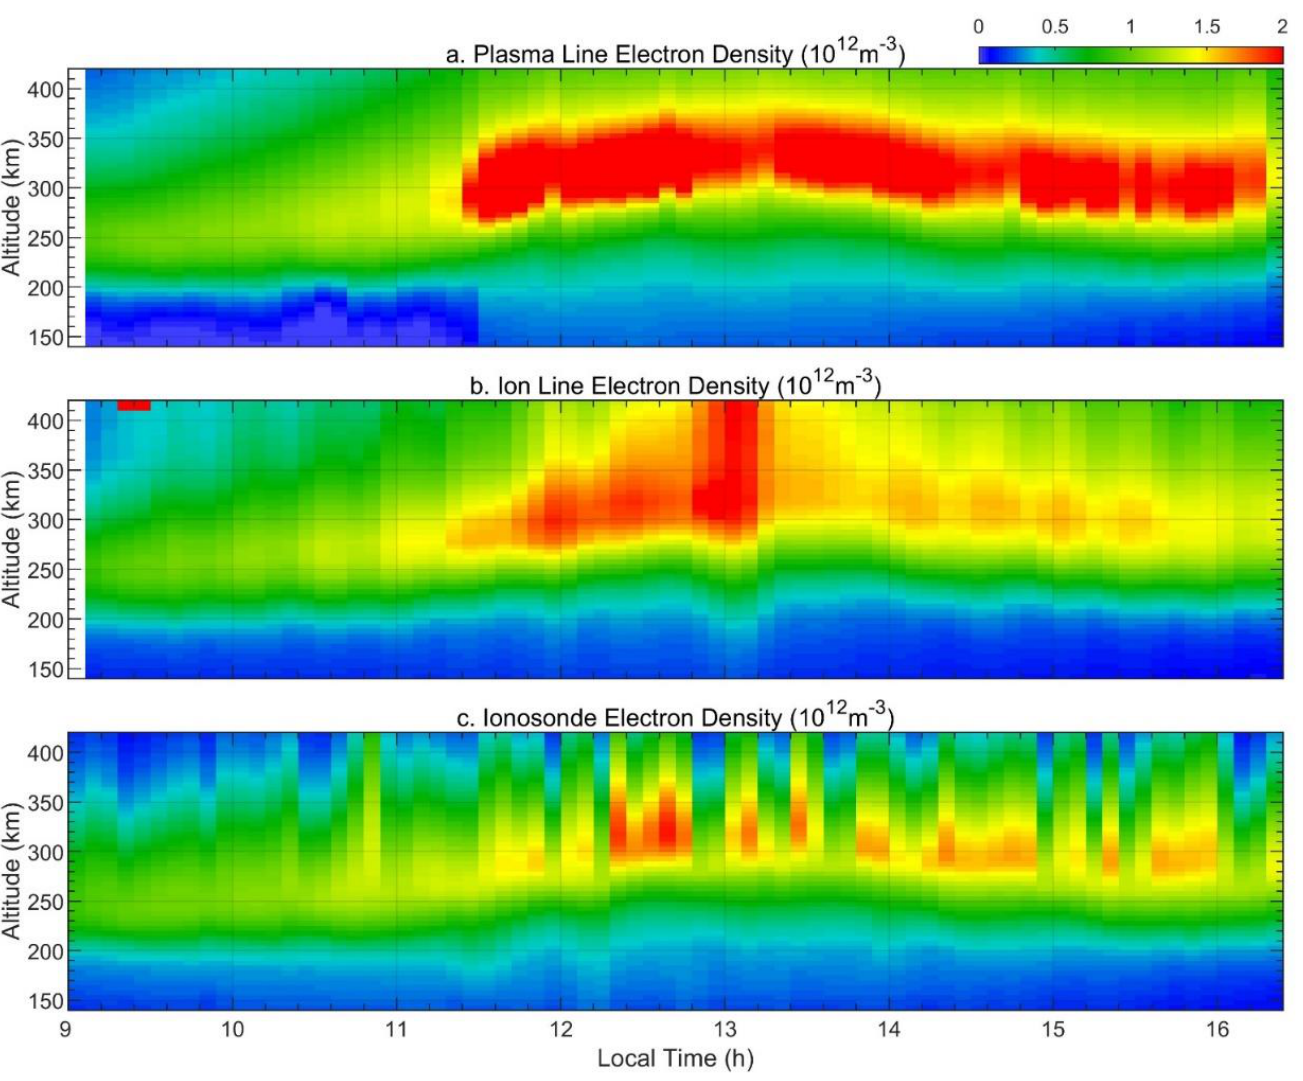
Figure 2. Local time variation of electron density profiles derived from simultaneous plasma line spec- tra ( a ) and ion line power (uncalibrated, ( b )) obtained by SYISR and a collocated ionosonde ( c )